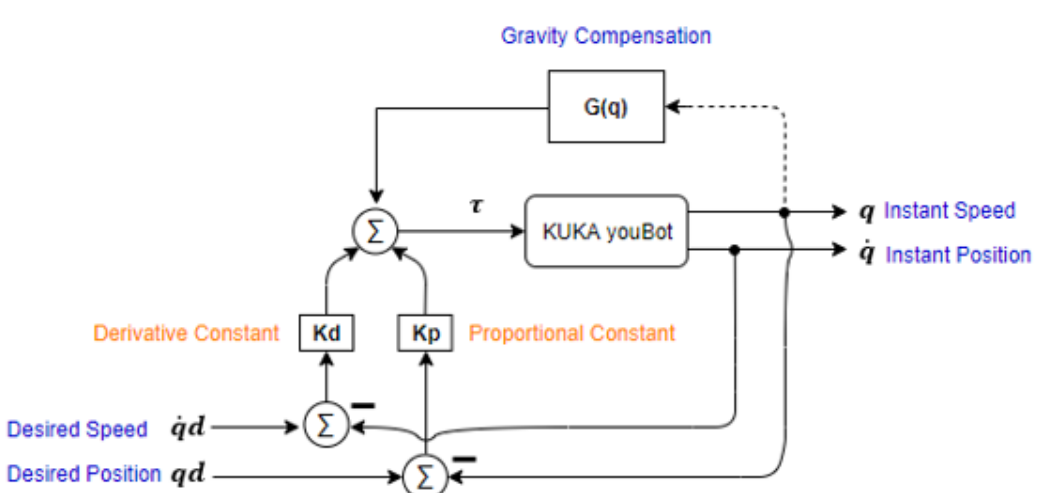
Figure 4. Dynamic Model for PD control with gravitational compensation.